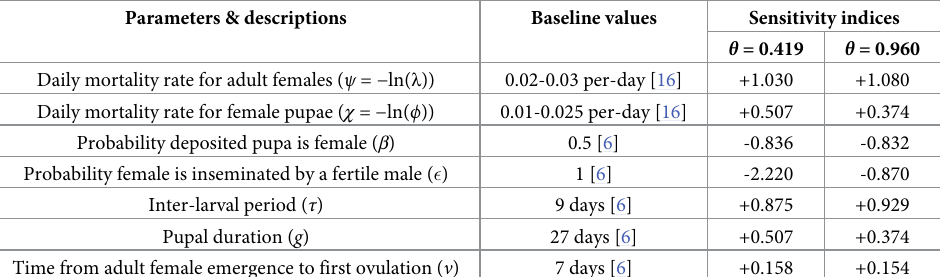
Table 2. List and description of parameters affecting extinction probabilities for tsetse populations, and the sensi- tivity indices for these parameters, at two different values of extinction probability. Parameters &